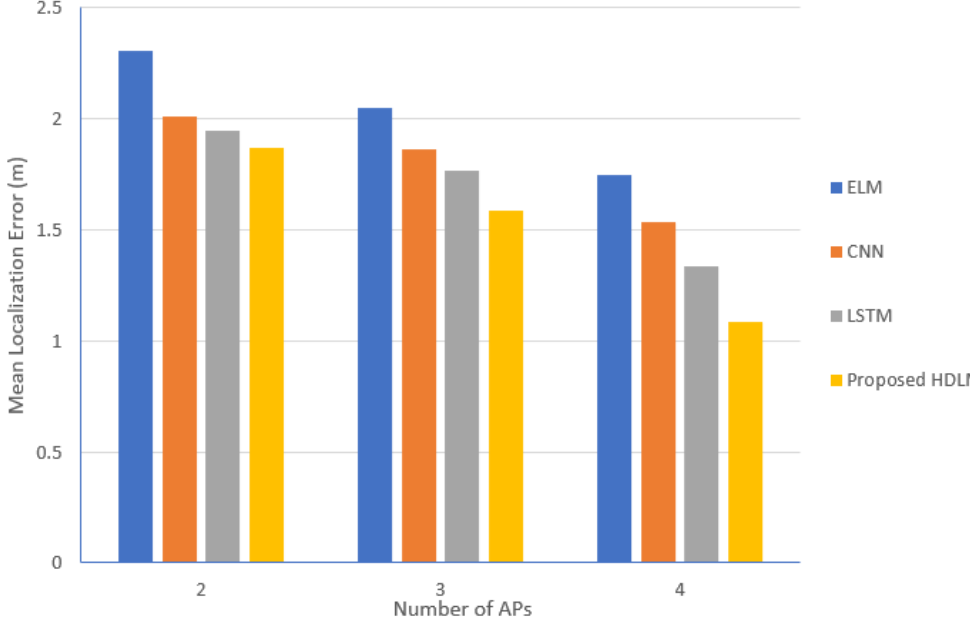
Figure 9. Mean localization error results with different number of